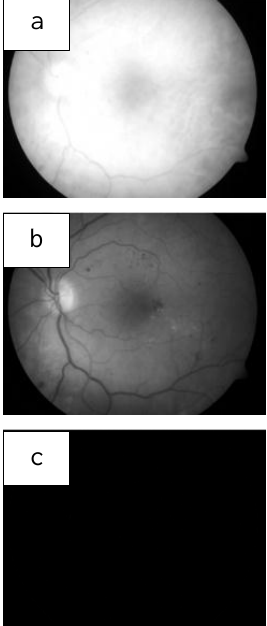
Fig. 3 The images results of channel extraction: (a) red;